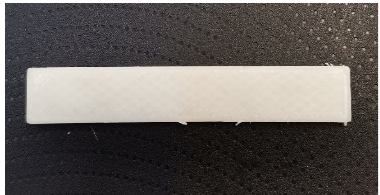
Figure 1. Macrograph of FOMM printed test specimen for flexural tests.